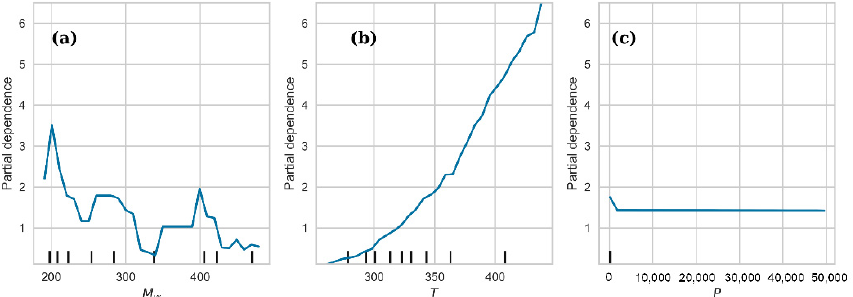
Figure 5 . Partial dependence plot, where each input is investigated on the effect on electrical conductivity ( σ ). conductivity ( σ ). ( a ) molecular weight; ( b ) temperature; ( c )